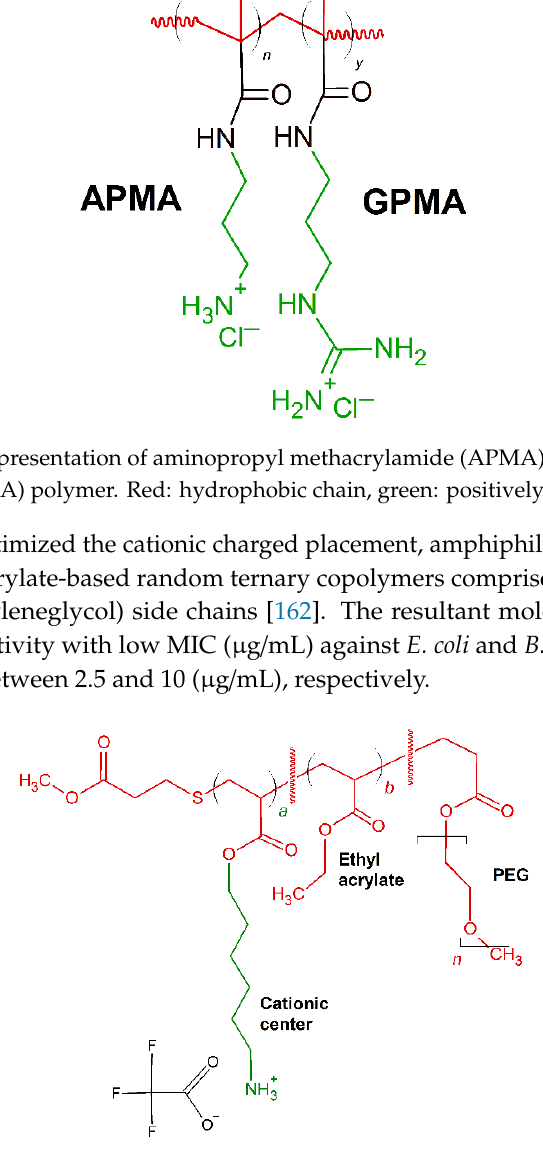
Figure 9. Schematic representation of the polycarbonate polymer with primary amino groups. Green: positively charged monomer; red: hydrophobic monomer. A new frontier in host defens e peptides mimicking is β -peptide polymers. Their potent antimicrobial activity and excellent biocompatibility, together with high stability upon protease associated biodegradation are well ascertained [163,164]. Recently, Chen et al. presented the new potent antimicrobial peptide polymer named 80:20 DM:Bu (Figure 10). It is composed of two subunits, one hydrophilic/cationic subunit (named DM) and one hydrophobic subunit (named Bu), to have both cationic charges and amphiphilicity as synthetic mimics of HDPs [27,28,32]. The polymer displayed fast, potent, and broad-spectrum activities upon multiple multi-drug resistant (MDR) strains of bacteria (MIC S. aureus ( μg/mL ) = 12.5; MIC s.haemolyticus ( μg/mL ) = 3.13; MIC P.aeruginosa ( μg/mL ) = 12.5; MIC E.coli ( μg/mL ) = 50), resistant to ampicillin (MIC S. aureus ( μg/mL ) > 200; MIC s.haemolyticus ( μg/mL ) > 200; MIC P.aeruginosa ( μg/mL ) > 200; MIC E.coli ( μg/mL ) > 200) and streptomycin (MIC S. aureus ( μg/mL ) = 25; MIC s.haemolyticus ( μg/mL ) > 200; MIC P.aeruginosa ( μg/mL ) > 200; MIC E.coli ( μg/mL ) = 100). Moreover, peptide polymer 80:20 DM:Bu exerted satisfactory activity against K. pneumoniae (MIC ( μg/mL ) = 50 – 100) and A. baumannii (MIC ( μg/mL ) = 12.5 – 50). Figure 10. Schematic representation of 80:20 DM:Bu polymer. Green: positively charged monomer; red: hydrophobic monomer.